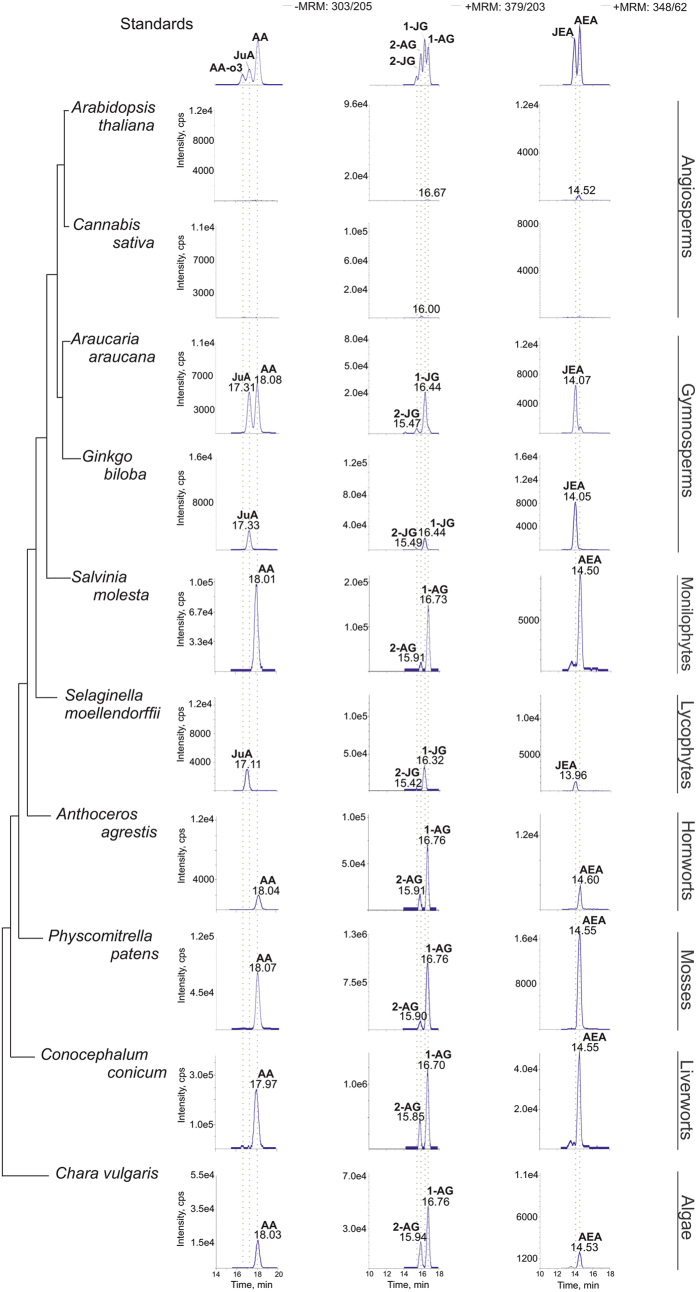
Chromatograms showing the analysis of C20 PUFA metabolites.First column: AA and JuA; second column: 1/2-AG and 1/2-JG and third column: AEA and JEA. Samples were prepared using HPLC for cleanup (see Sample preparation for identification) and analyzed using LC-MS/MS in the positive and negative modes (see Chromatographic conditions used for the identification of structural isomers (LC-MS/MS method 2)).